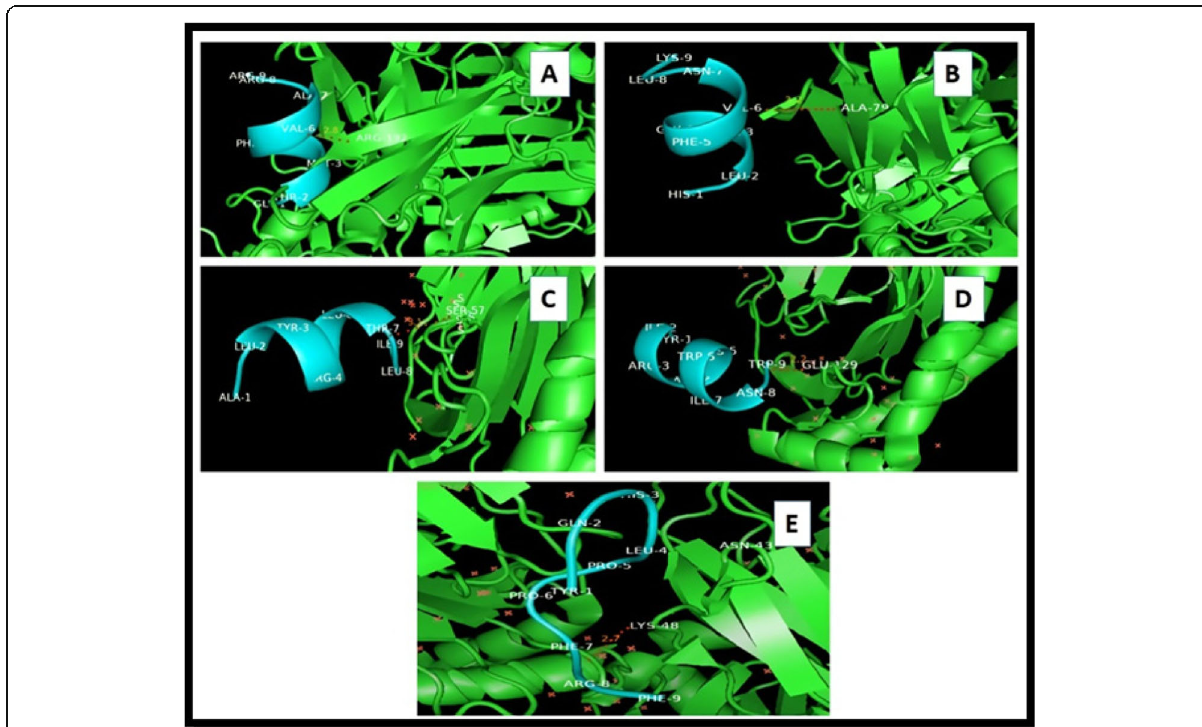
Fig. 1 Docked complexes: A 5F1I-GTMNFVARR (2.8ÅHydrogen bond Arg192 to Val6). B 5F1I-HLQGFVNLK (3.2Å Hydrogen bond Ala79 to Val6). C 7CJQ-ALYRRLTLI (3.1Å Hydrogen bond Ser57 to Thr7). D 7CJQ-YIRAKWINW (2.2Å Hydrogen bond Glu129 to Trp9). E 7CJQ-YQHLPP FRF (2.7Å Hydrogen bond Lys48 to Phe7)